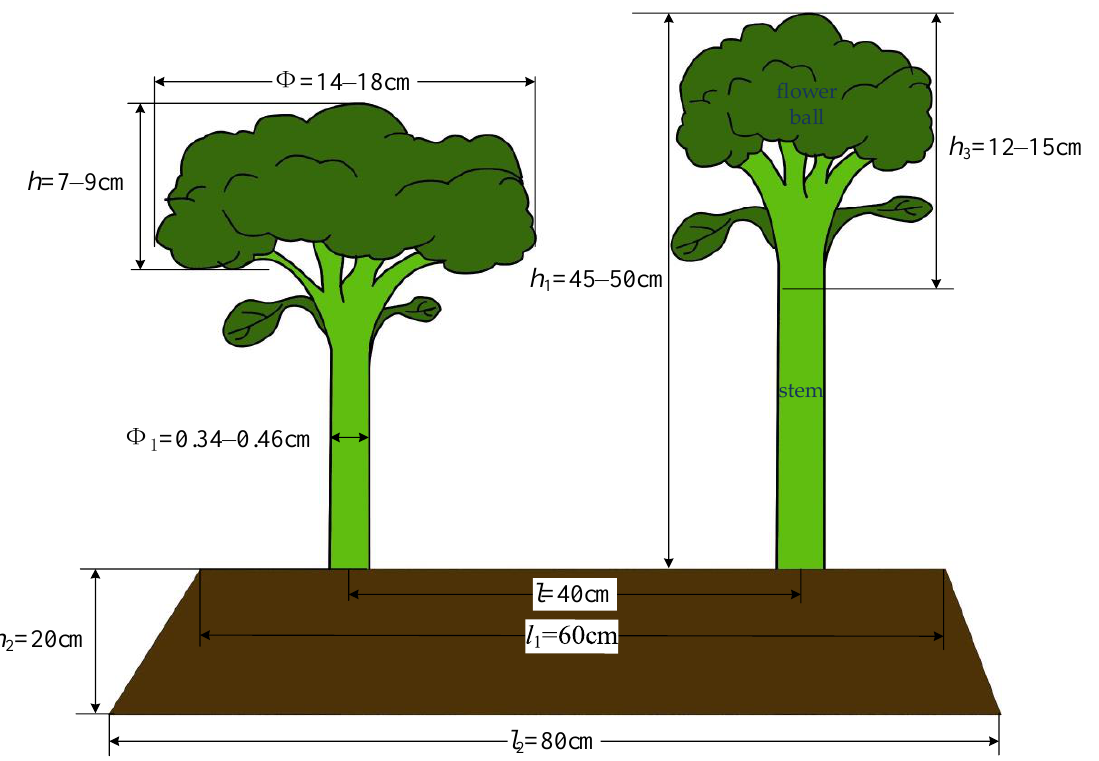
Figure 1. Planting patterns and biological characteristics of broccoli.